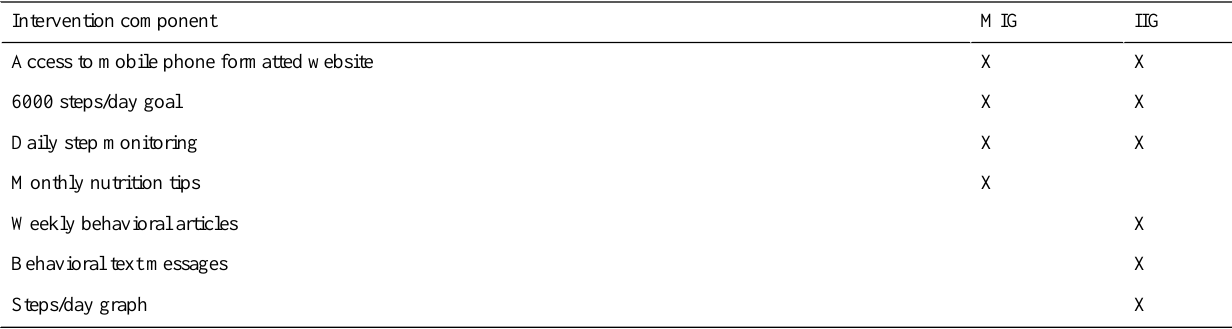
Table 1. Components of the minimal (MIG) and intensive (IIG) intervention groups.